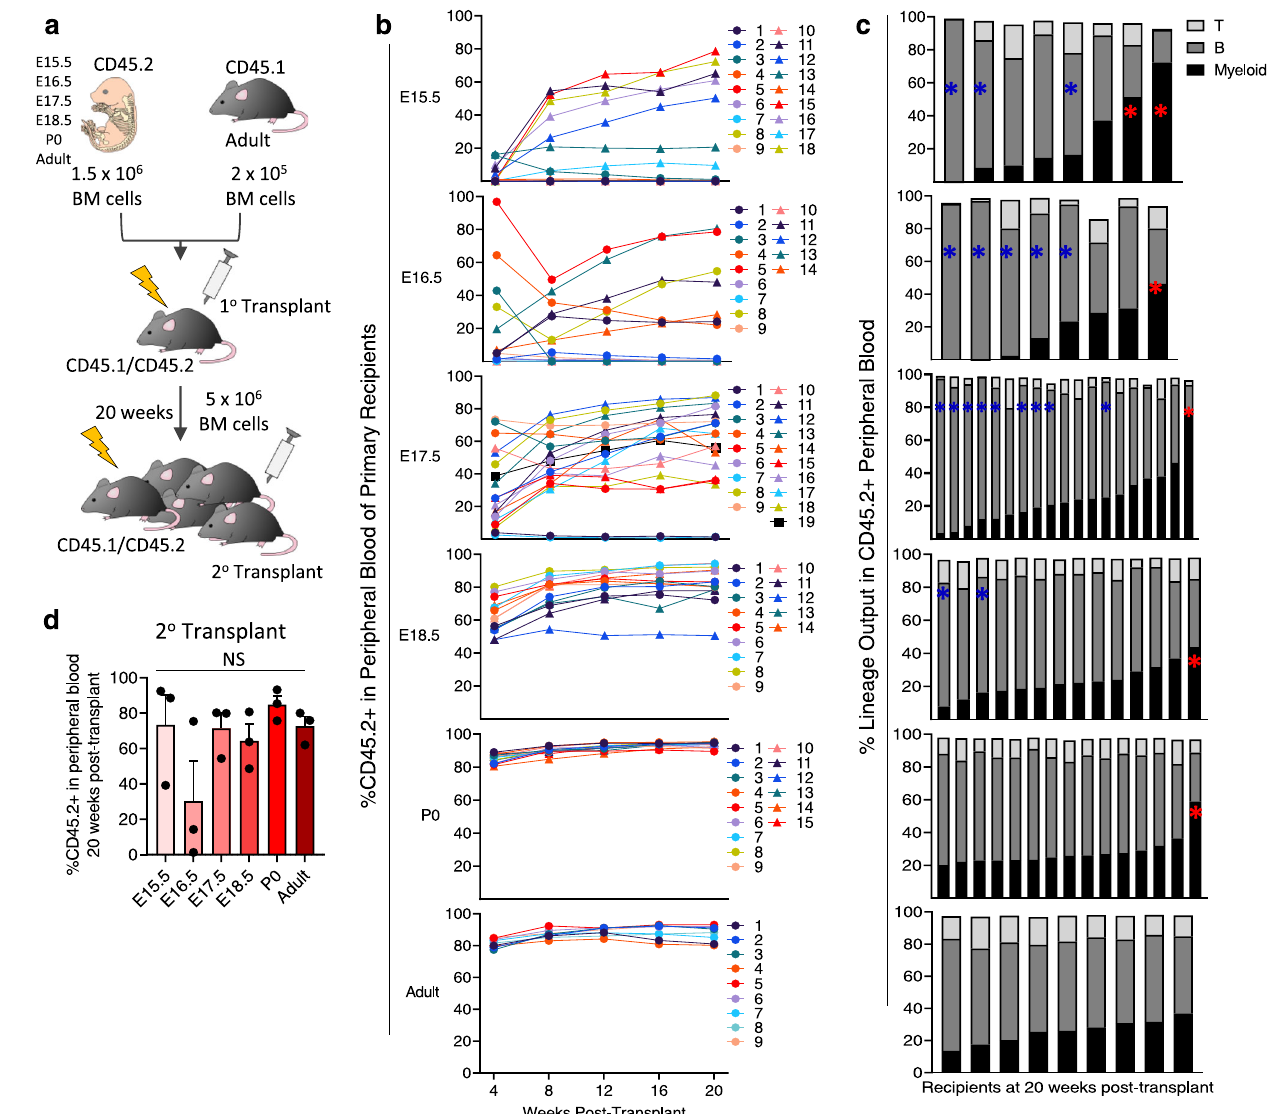
Fig.1|Long-termrepopulatingcellsaredetectedinFBMatE15.5.a FBMprimary andsecondarytransplant. b PBreconstitutioninFBMprimaryrecipients( n =9 –